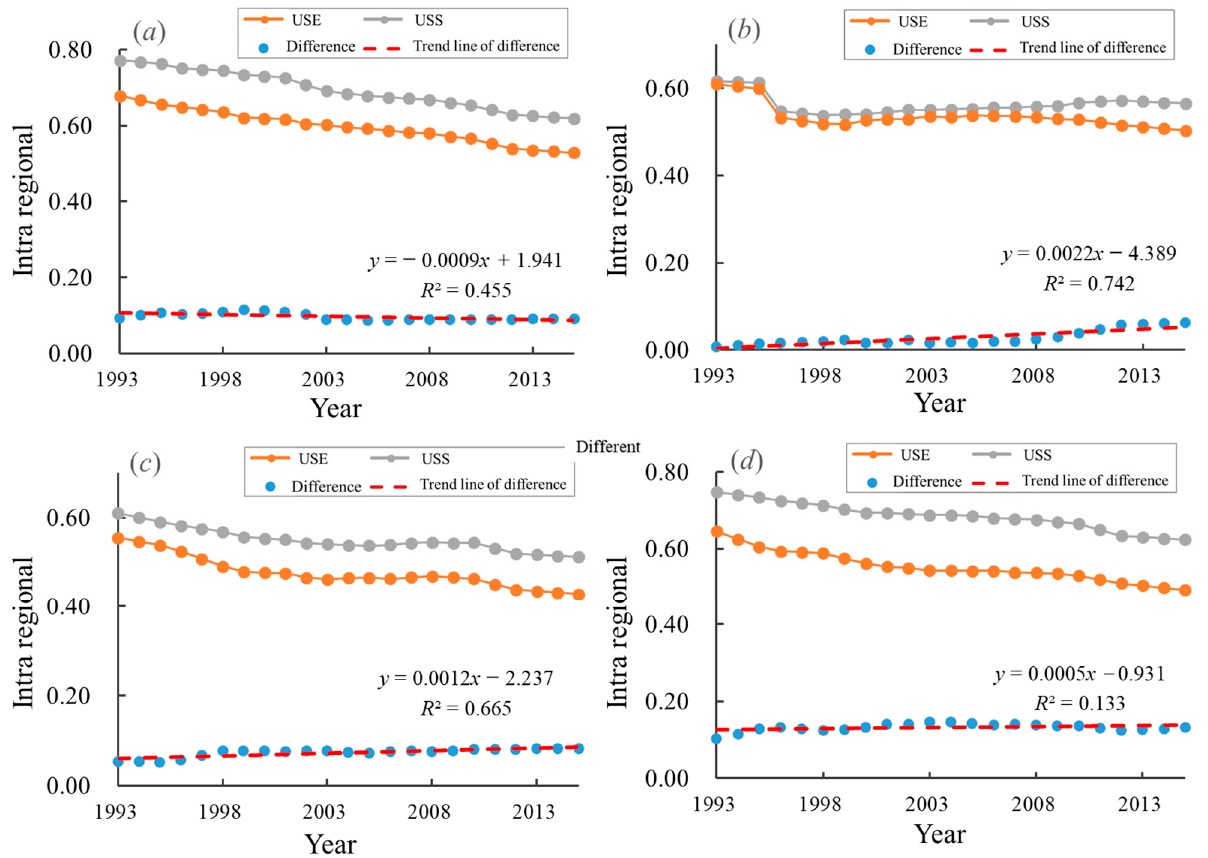
Figure 9. Differences between USS and USE in different regions: ( a ) ER, ( b ) NER, ( c ) CR, and ( d ) WR. Note: USS is urban spatial expansion; USE is urban socioeconomic expansion.